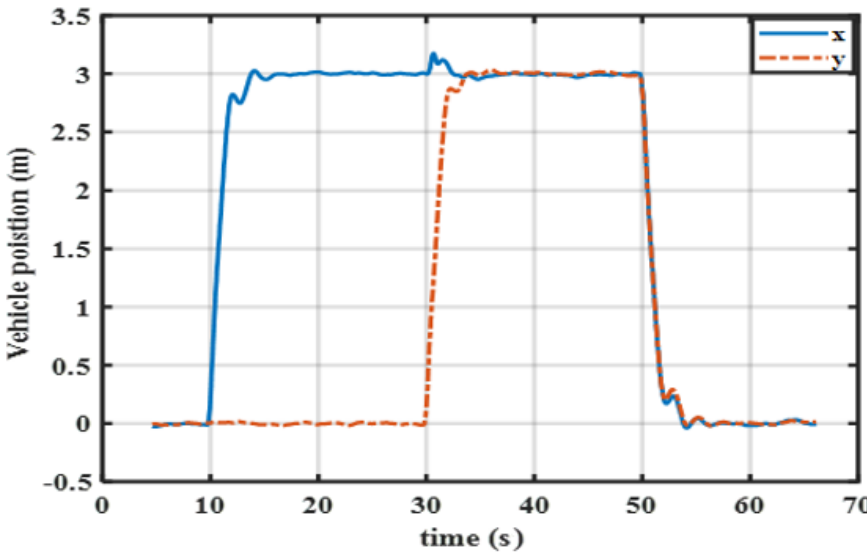
Figure 23. Time history of the quadrotor position during travel maneuver with the ASC.